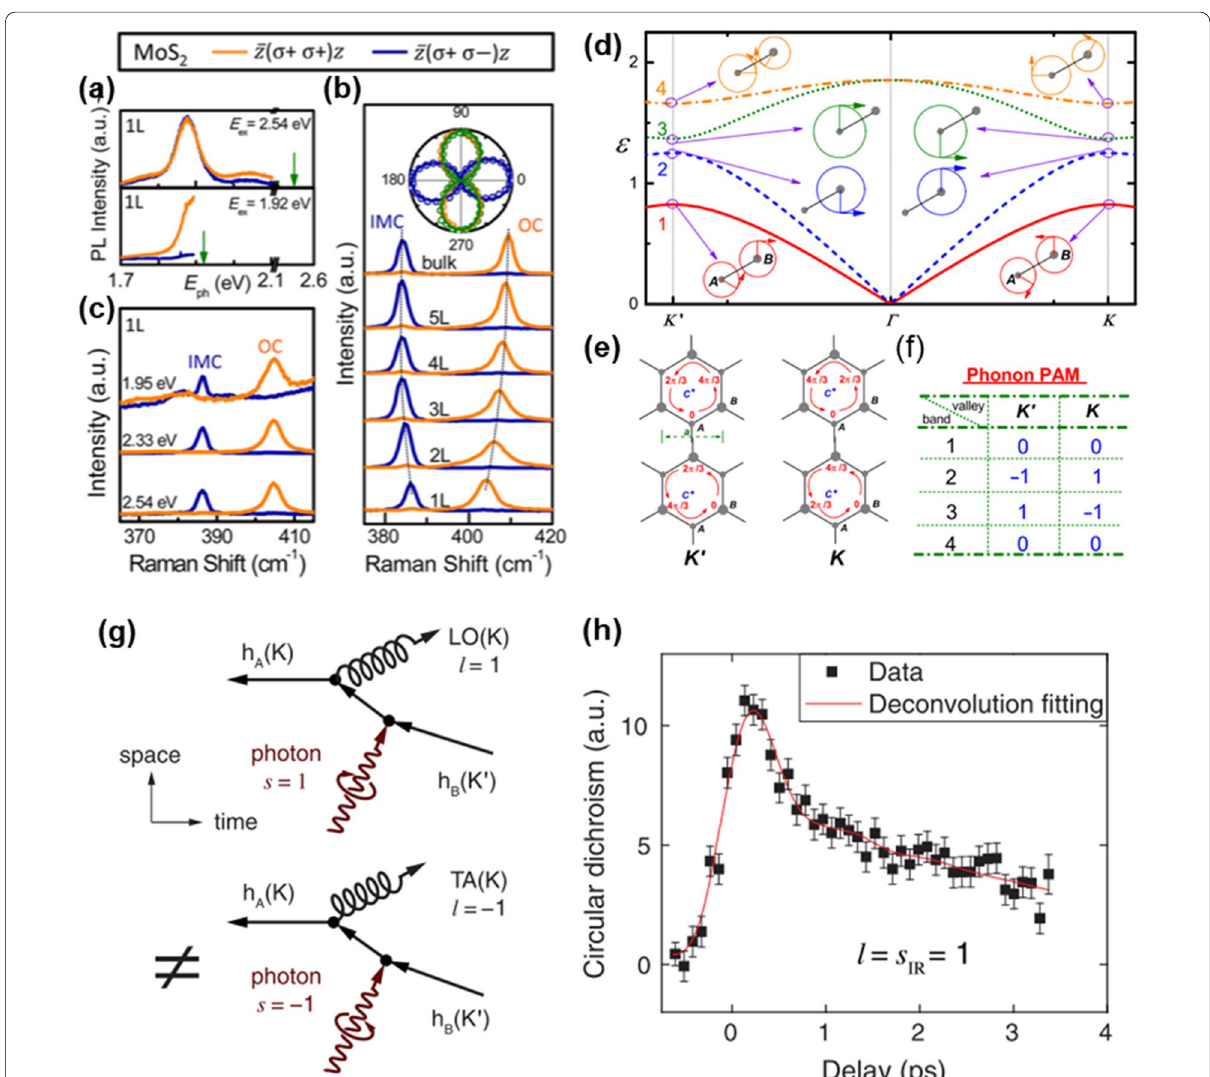
Fig. 21 a The helicity-resolved photoluminescence of monolayer MoS 2 at 80 K with excitation photon energy at 2.54 eV (upper) and 1.92 eV (lower). b The helicity-resolved Raman spectra (488 nm with σ polarization) of MoS 2 from monolayer to bulk. Inset: normalized angular + dependence of the Rayleigh (green), IMC (blue), and OC phonon (orange) scattering intensities for monolayer MoS 2 . c Raman scattering with various excitation intensities. Reproduced with permission from [133]. d Phonon dispersion relation of a honeycomb AB lattice. The radii of circles denote vibration amplitudes; phase and rotation direction are included. e Phase correlation of the nonlocal phonon part for sublattice A (upper two panels) and sublattice B (lower two panels). Reproduced with permission from [128]. f PAM for bands 1 to 4 at valleys K’ and K. g Diagram of indirect optical transition for the LCP and RCP IR photons. h The measured CD in time-domain at 82 K. Reproduced with permission from